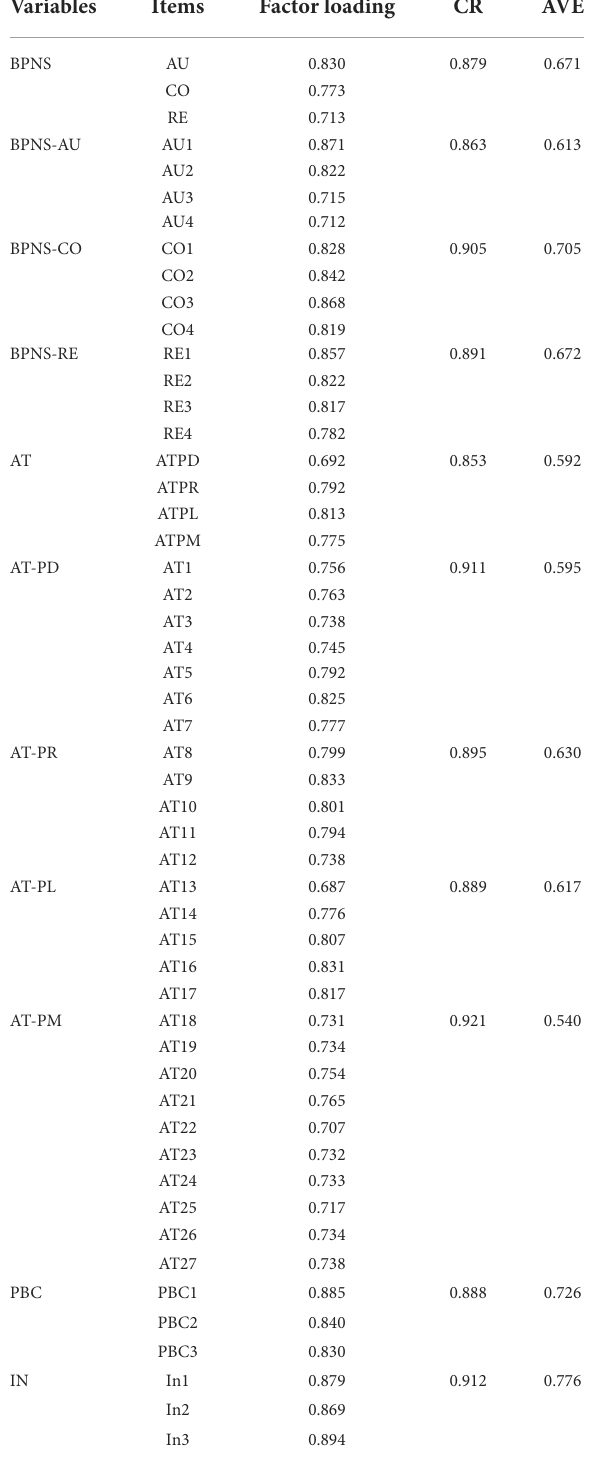
TABLE 3 Convergent validity analysis of scales. TABLE 4 Discrimination validity: Pearson correlation and AVE square